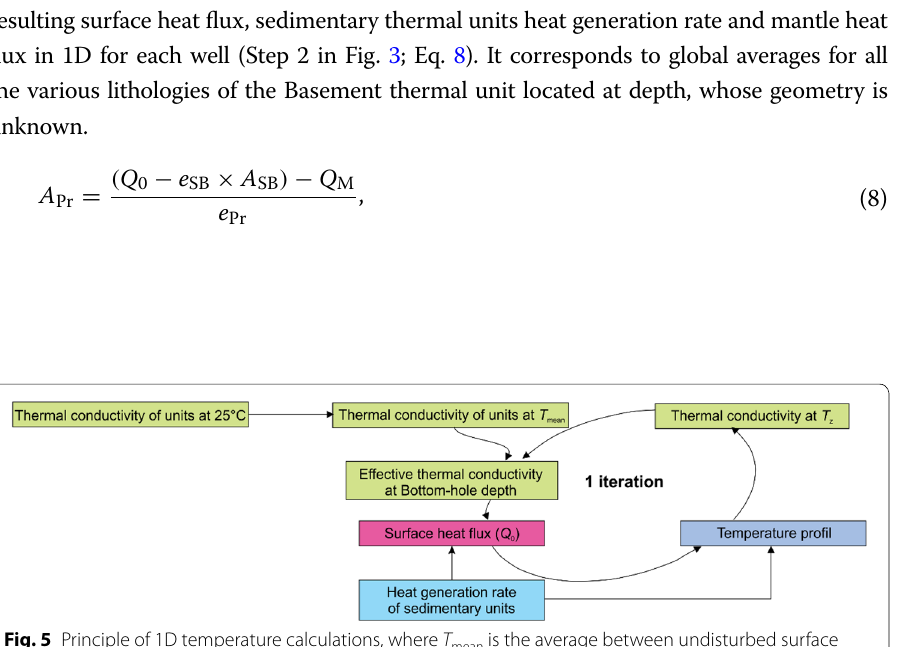
Fig. 5 Principle of 1D temperature calculations, where T mean is the average between undisturbed surface temperature and